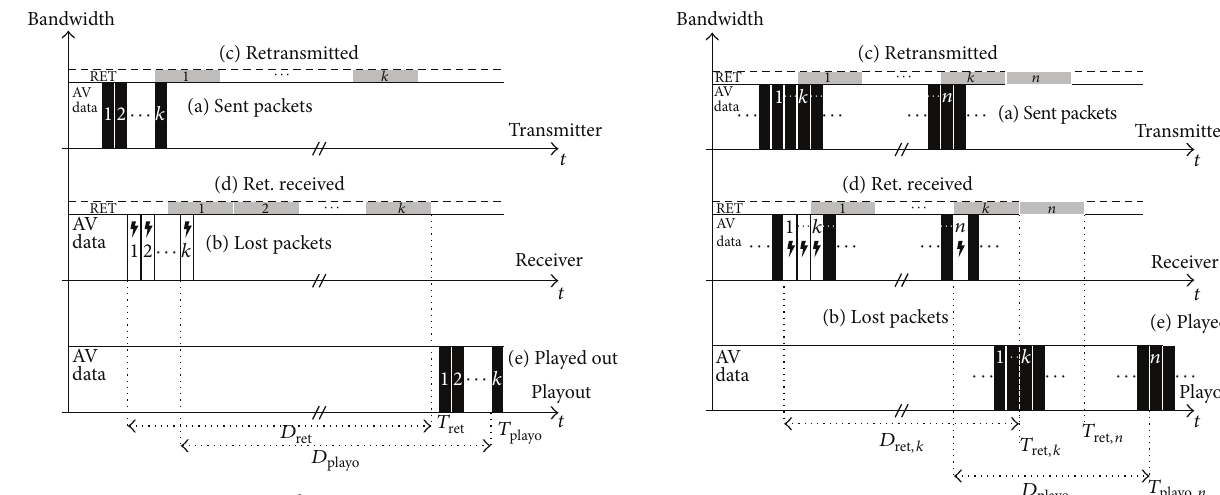
Figure 4: Intraburst retransmission.